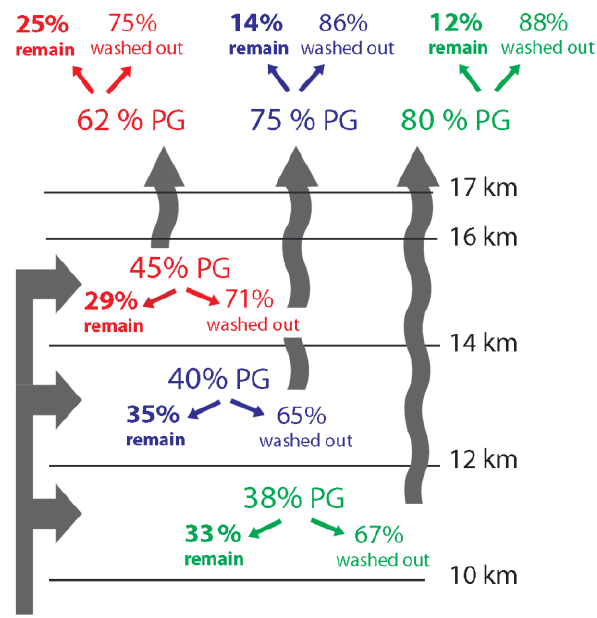
Fig. 7. For all air masses which encounter fast uplift by convection PG at the moment of detrainment from convection is given relative to the total amount of bromine originally contained in the air mass. Based on the amount of PG the fraction of effectively remaining PG (not washed out) and the fraction of lost PG (washed out) are given for air masses entrained between 10 and 12km (green), 12 and 14km (blue), and 14 and 16km (red). Also displayed in the upper part of the figure are the same quantities at the moment of entrainment above 17 km.